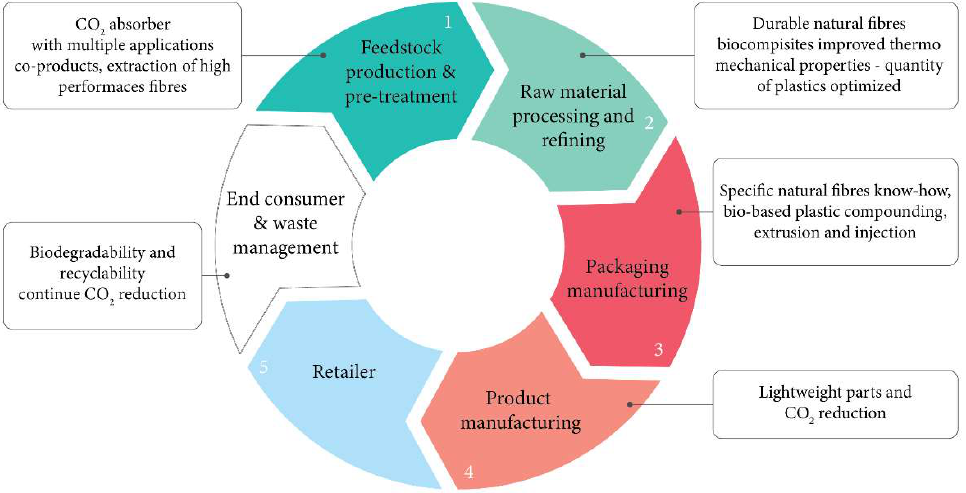
Figure 1. The conceptual model of the value chain of sustainable industrial consumption and related benefits from biocomposites (source: the authors).